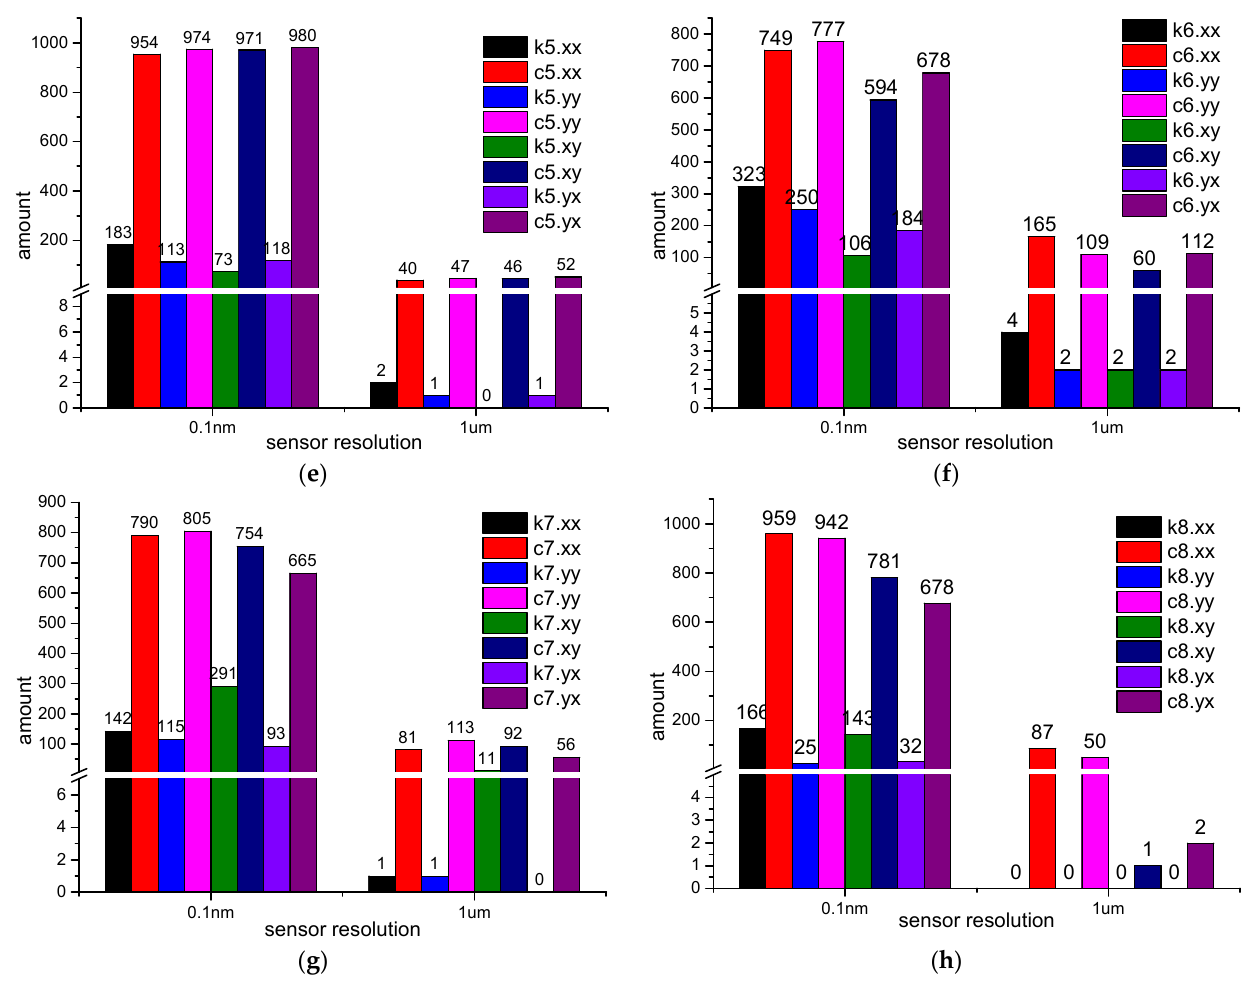
Figure 9. Statistical results of the amount of the frequencies, at which the related error is less than 10% or the absolute value is less than 10: ( a ) #1 bearing; ( b ) #2 bearing; ( c ) #3 bearing; ( d ) #4 bearing; ( e ) #5 bearing; ( f ) #6 bearing; ( g ) #7 bearing; ( h ) #8 bearing. Simulations Results Based on Algorithm I